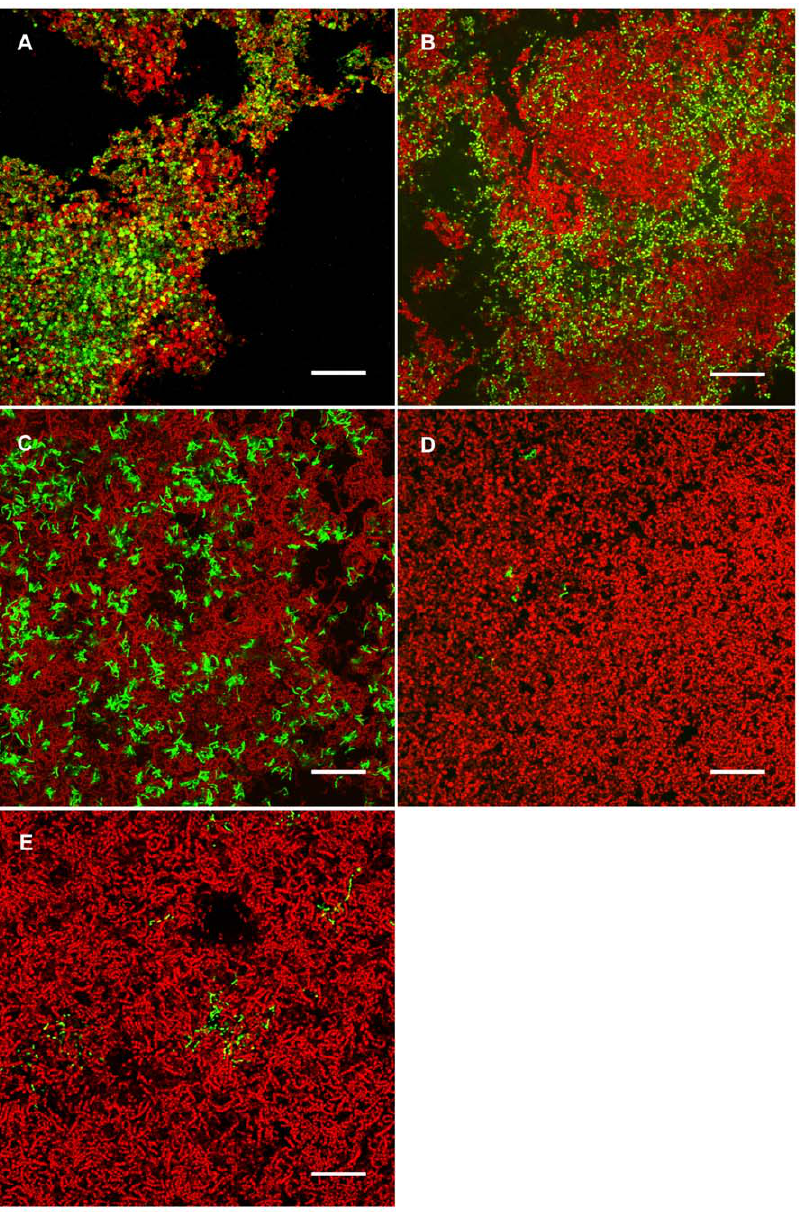
Figure 1. Biofilms hybridized with EUB338 and species-specific probes SMIT, SSAN, SORA2, SDOW or ANAES. EUB338 was labelled with Atto633 (red), species-specific probes were labelled with Cy3 (green). A. Biofilms were dominated by S. mitis SK24. B. Colonies of S. sanguinis SK150, shown in close colocalization with other streptococcal species. C. Cells of A. naeslundii AK6 formed branched spider-like colonies in basal layers of the biofilms. D. Small groups of S. oralis SK248 cells were scattered over the biofilm. E. Cells of S. downei HG594 appeared in particularly long chains intertwined with clusters of other streptococcal cells. Bars=20 m m.